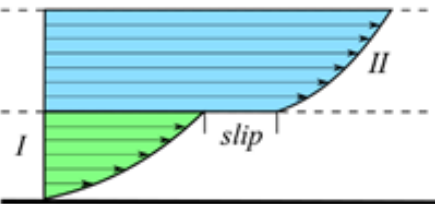
Figure 25. Velocity profiles in coextrusion of different polymer melts with a slip at the interface between polymers I and II .